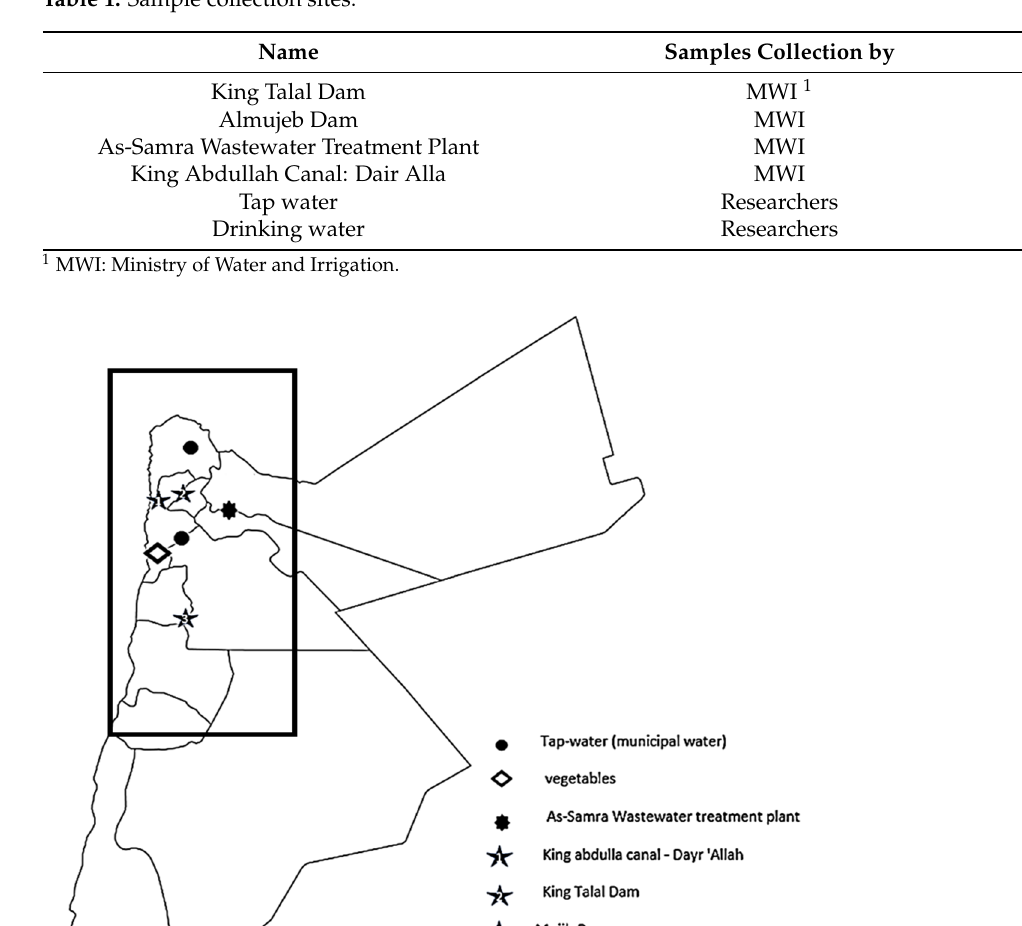
Table 1. Sample collection sites.